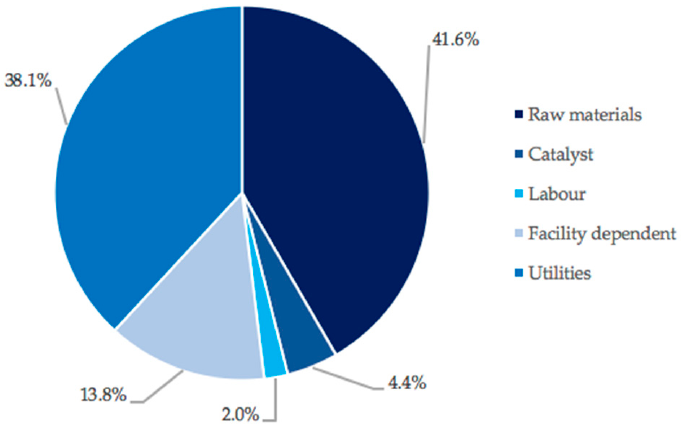
Figure 4. Breakdown of Area 2 operating expenses.